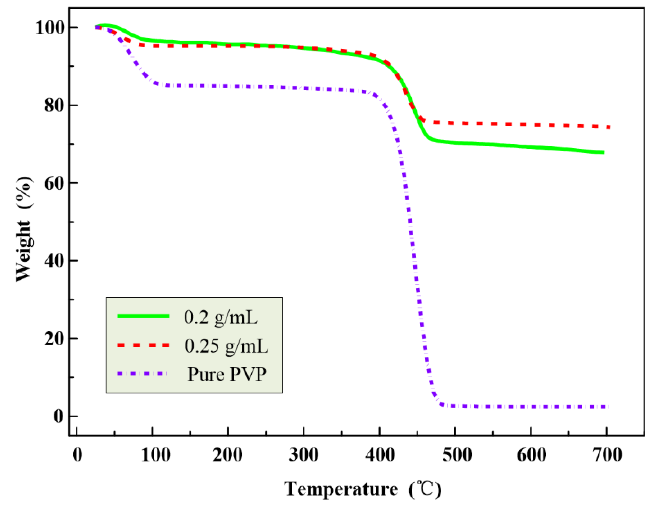
Figure 4. TGA curves of PVP/Fe 3 O 4 and pure PVP nanofibers.